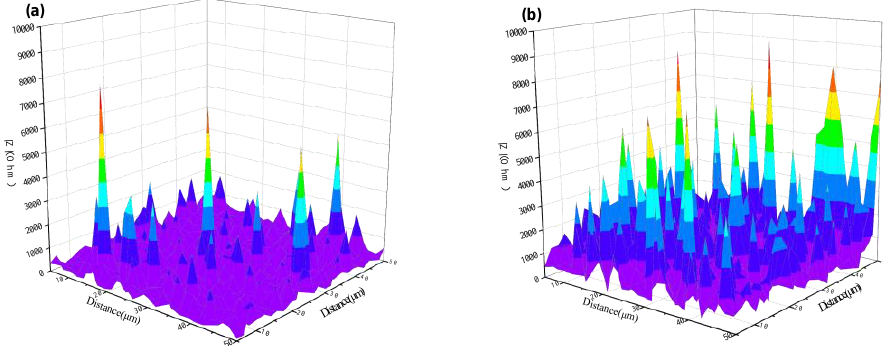
Figure 11. LEIS of ( a ) forged and ( b ) SLMed Ti-6Al-4V alloys in 0.1 mol/L NaOH.